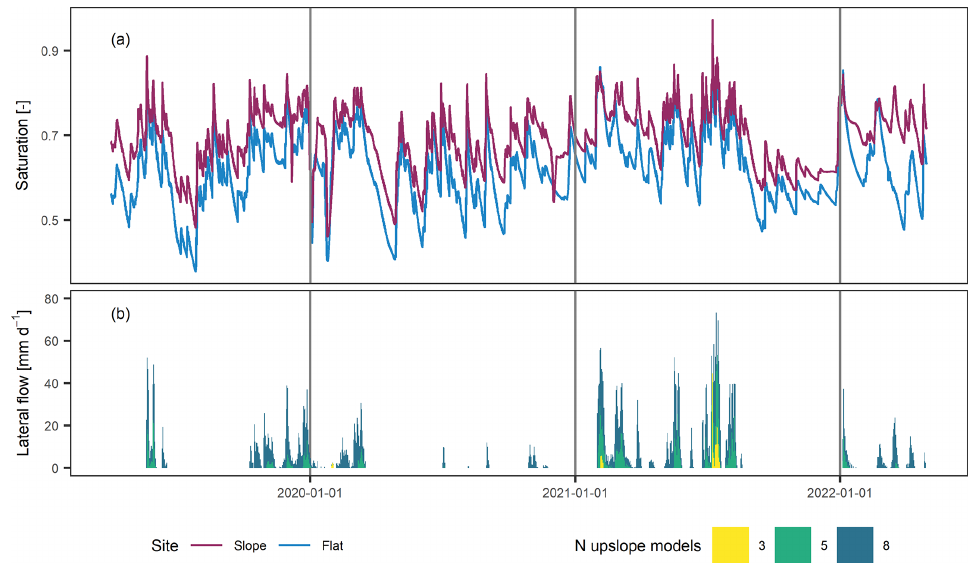
Figure 13. Simulated soil moisture variation at the sloped and the flat location (number of upslope models defining lateral flow at sloped site was five) (a) and simulated lateral water flow at the sloped site in the uppermost 2m as a function of the number of upslope models (b) .